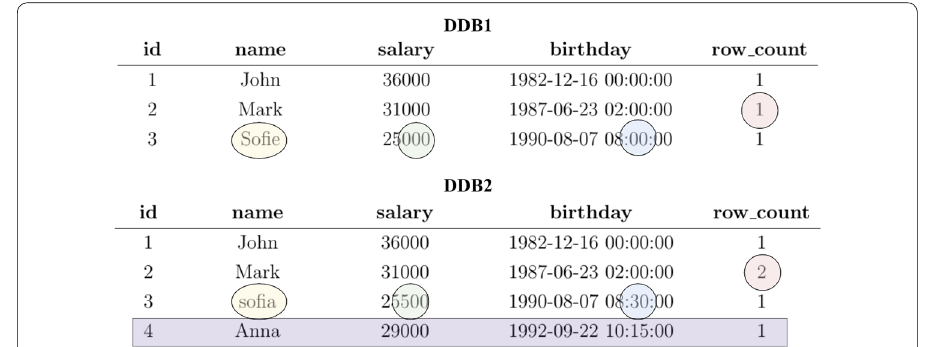
Fig. 8 Row differences between “Users" table in “DDB1" and “DDB2"